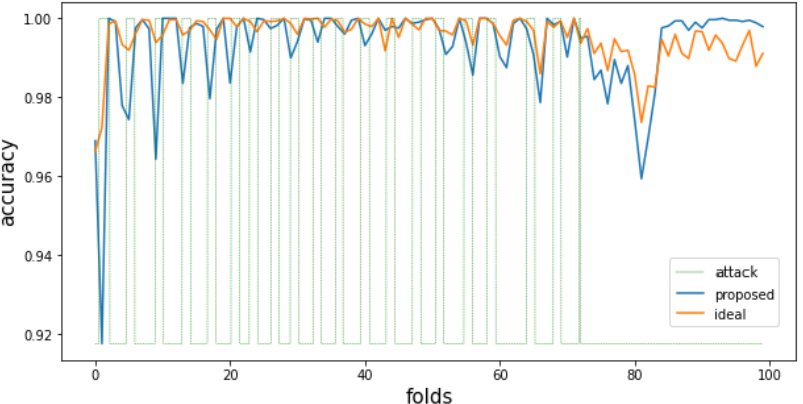
Figure 5. Attack classification accuracy of the proposed and ideal methods when the size of the pure dataset is 20,000 and the proportion of attack data is